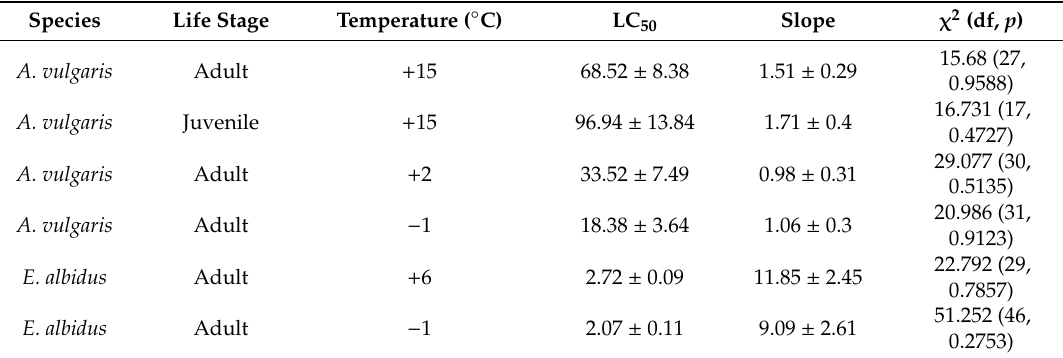
Figure 1. Dose–response curves for the toxicity of solution of Quillaja saponaria aqueous extract (QE) on: ( A ) A. vulgaris adults at 15 ◦ C; ( B ) A. vulgaris juveniles at 15 ◦ C; ( C ) A. vulgaris adults at 2 ◦ C; ( D ) A. vulgaris adults at − 1 ◦ C. A grey band on the curve represents the standard error of the dose–response model. Black dots show the mean (with standard error bars) e ff ect of the tested concentration of QE solution. Black dots represent tested concentrations of QE solution: 0; 25; 50; 100; 150 g / L ( A and B ) and 0; 10; 20; 50 g / L ( C and D ). Table 2. Dose–response parameters of Quillaja aqueous extract for slugs and worms in g / L (average ± standard